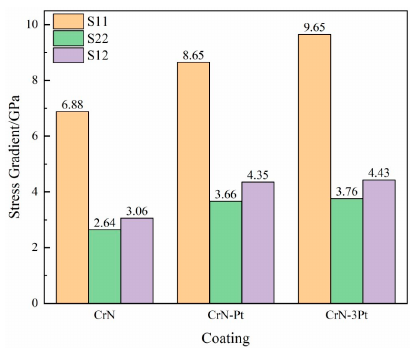
Figure 18. Isotropic residual stress gradient at the interface between the three coatings and substrate.